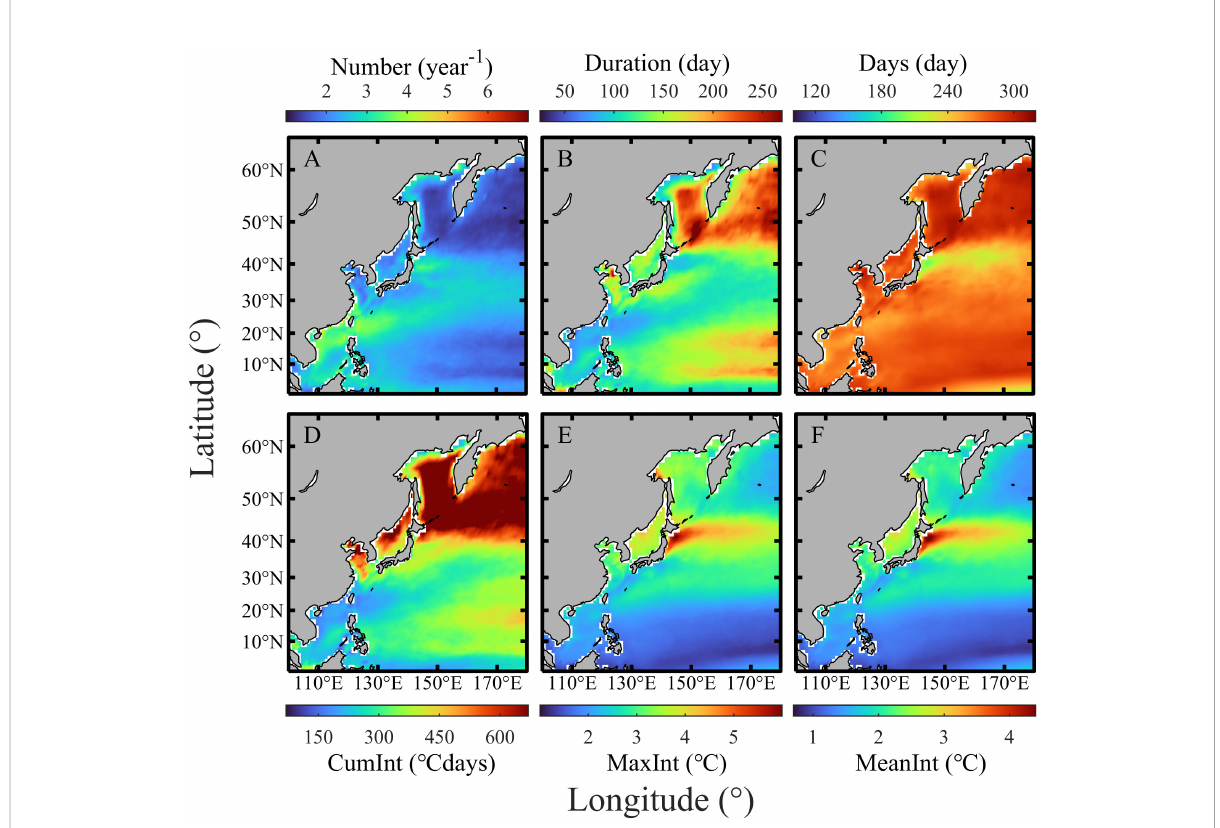
FIGURE 8 Spatial distribution of projected (2015 ~ 2100) MHWs characteristics in the WNPCC area under the SSP5-8.5 scenario. Multi-year average of (A) MHWs Number (units: year -1 ), (B) Duration (units: day), (C) Days (units: day), (D) CumInt (units: °C days), (E) MaxInt (units: °C), and (F) MeanInt (units: